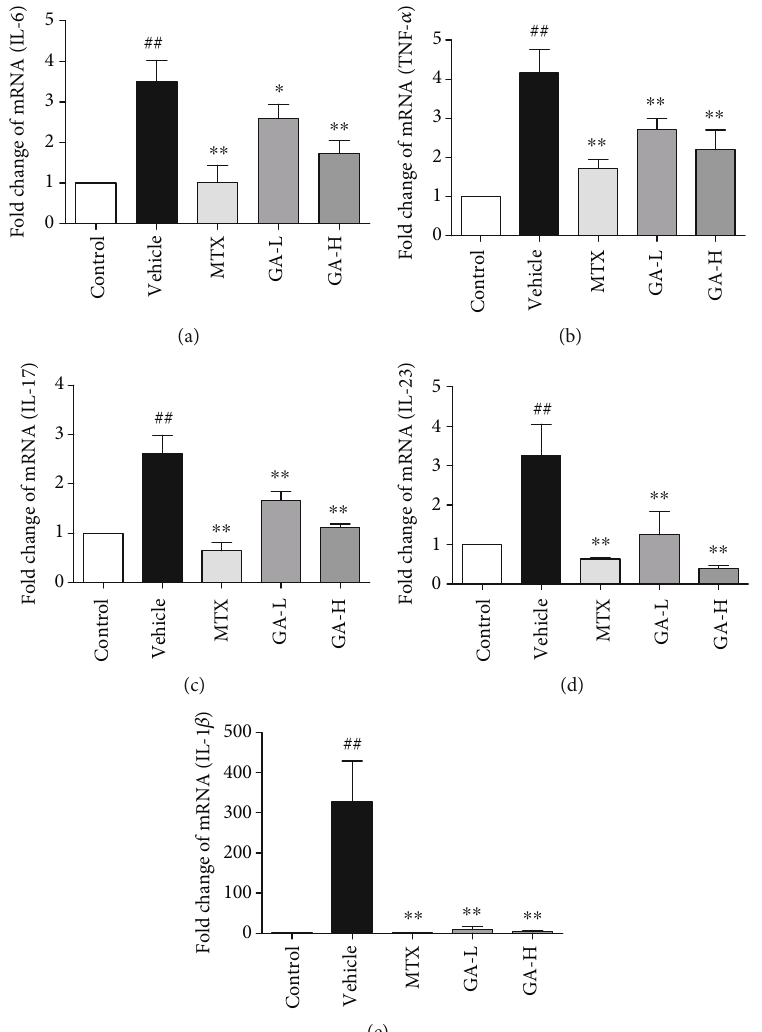
Figure 4: E ff ect of GA on the mRNA expression of in fl ammatory cytokines in imiquimod-induced psoriasis. Mice were administrated with distilled water, MTX and GA (60 and 120mg/kg, respectively) for 7 days, and topically administrated with imiquimod. The mRNA levels of IL-6 (a), TNF- α (b), IL-17 (c), IL-23 (d), and IL-1 β (e) in the skin were determined using RT-PCR. Data shown are the means ± SD ( n = 3 , # P < 0 : 05 and ## P < 0 : 01 compared with control group, ∗ P < 0 : 05 and ∗∗ P < 0 : 01 compared with vehicle